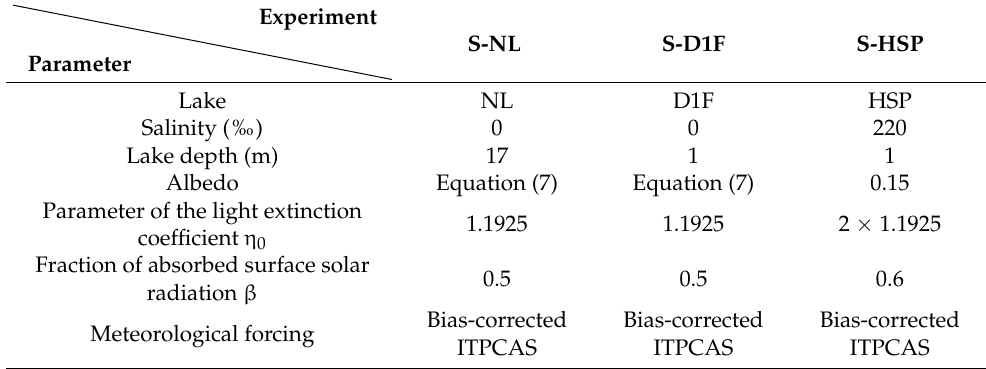
Table 1. Numerical experiments S-(Lake) and model parameters. Experiment S-NL S-D1F S-HSP Parameter Lake NL D1F HSP Salinity (‰) 0 0 220 Lake depth (m) 17 1 1 Albedo Equation (7) Equation (7) 0.15 Parameter of the light extinction 1.1925 1.1925 2 × 1.1925 coefficient η 0 Fraction of absorbed surface solar 0.5 0.5 0.6 radiation β Bias-corrected Bias-corrected Bias-corrected Meteorological forcing ITPCAS ITPCAS